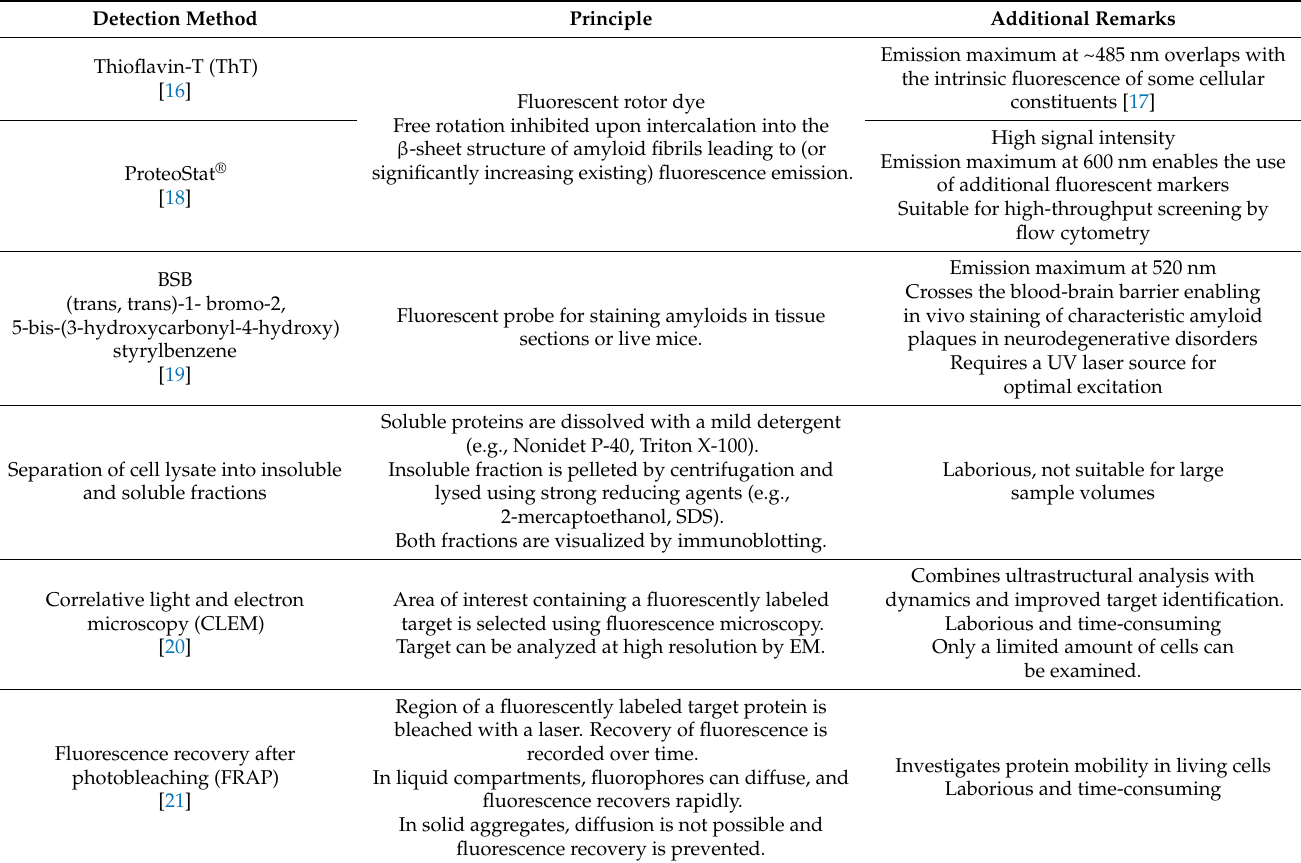
Table 1. Selected methods for detection of protein aggregates in cells. The listed methods make use of fluorescent dyes, solubility properties of aggregates, and different microscopy